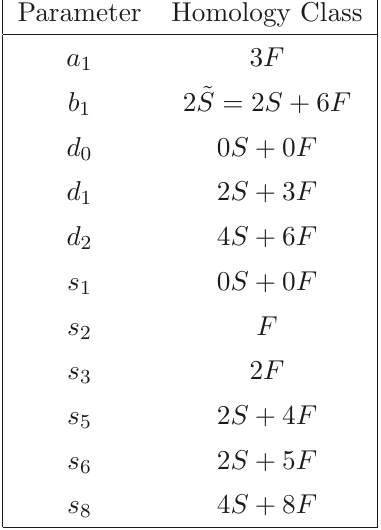
Table 3 . Homology classes for the parameters of the charge-4 Weierstrass model on F 3 .